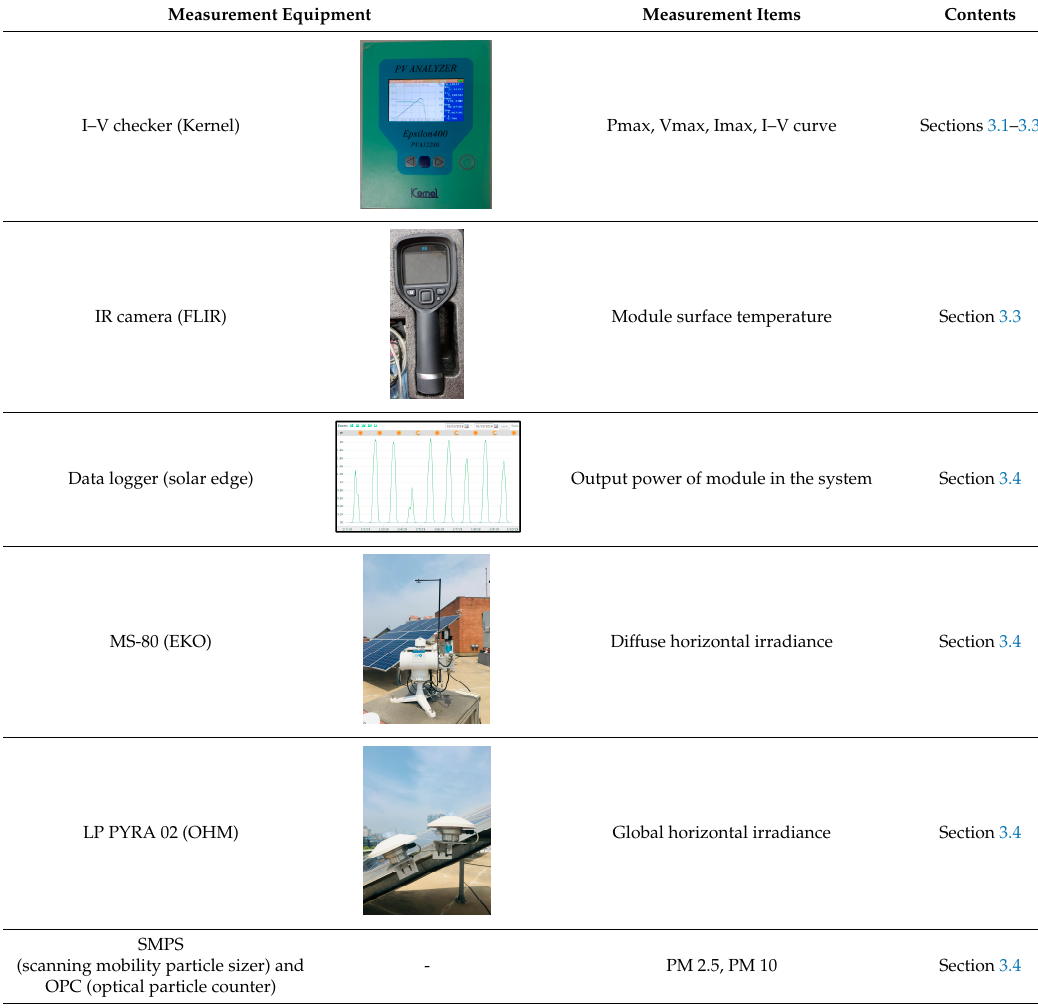
Table 5. Measurement equipment and items.